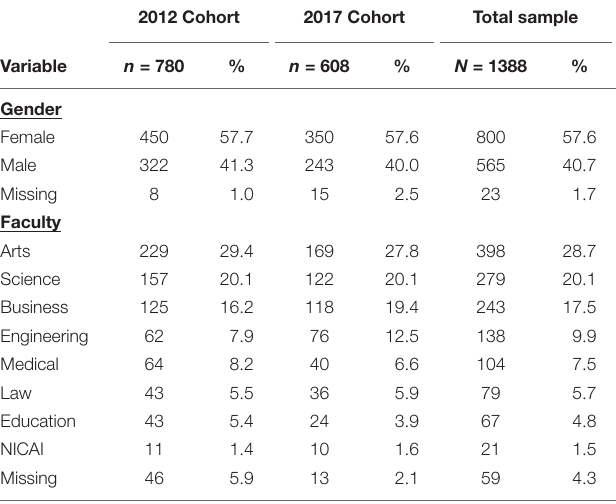
TABLE 1 | Participants’ gender and faculty by cohort: frequencies and